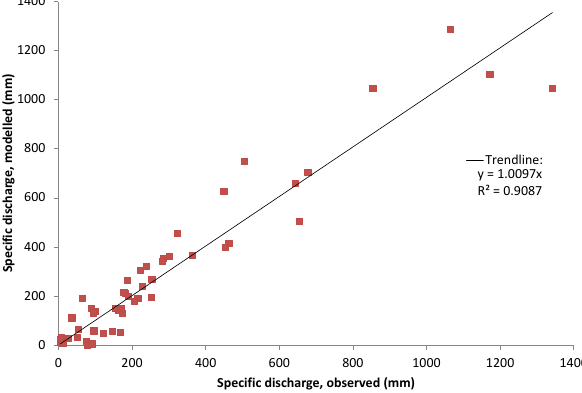
Figure 2. Graphic representation of validation results in which modelled specific river discharges are compared to observed spe- cific river discharges.